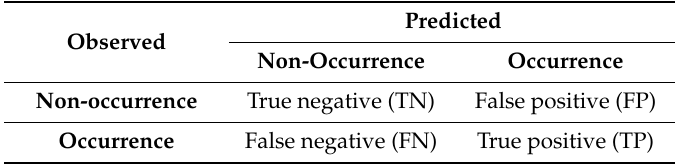
Table 4. Contingency matrix used for evaluation of